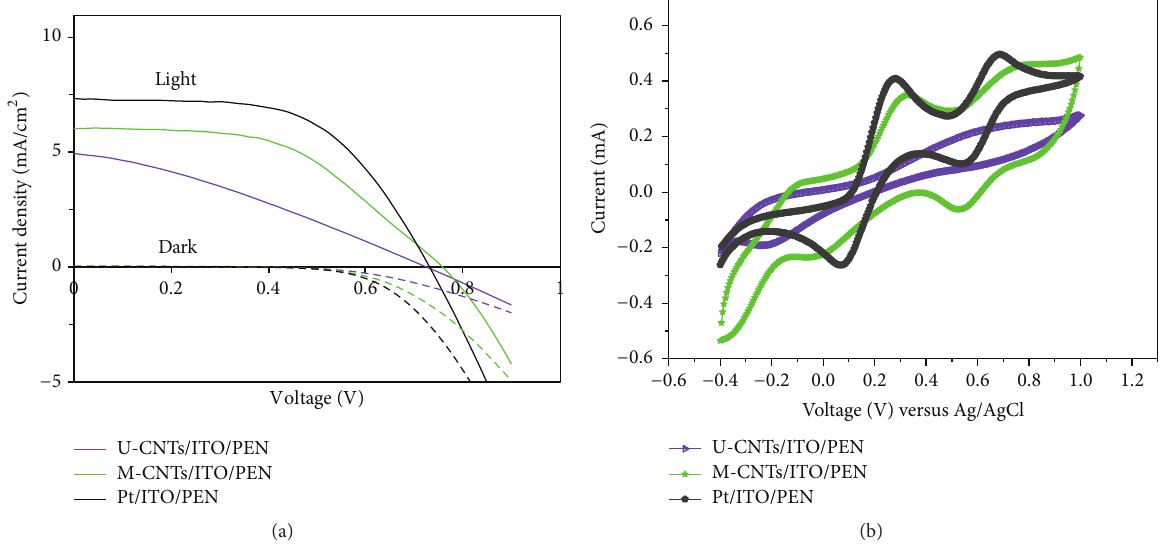
Figure 9: (a) 𝐽 - 𝑉 curve of flexible DSSCs of the Pt/ITO, U-CNTs/ITO, and M-CNTs/ITO CEs. (b) CV curves of the Pt/ITO, U-CNTs/ITO, and M-CNTs/ITO films in acetonitrile solution of 5 mM LiI, 1mM I 2 , and 0.1M LiClO 4 at the scan rate of 20